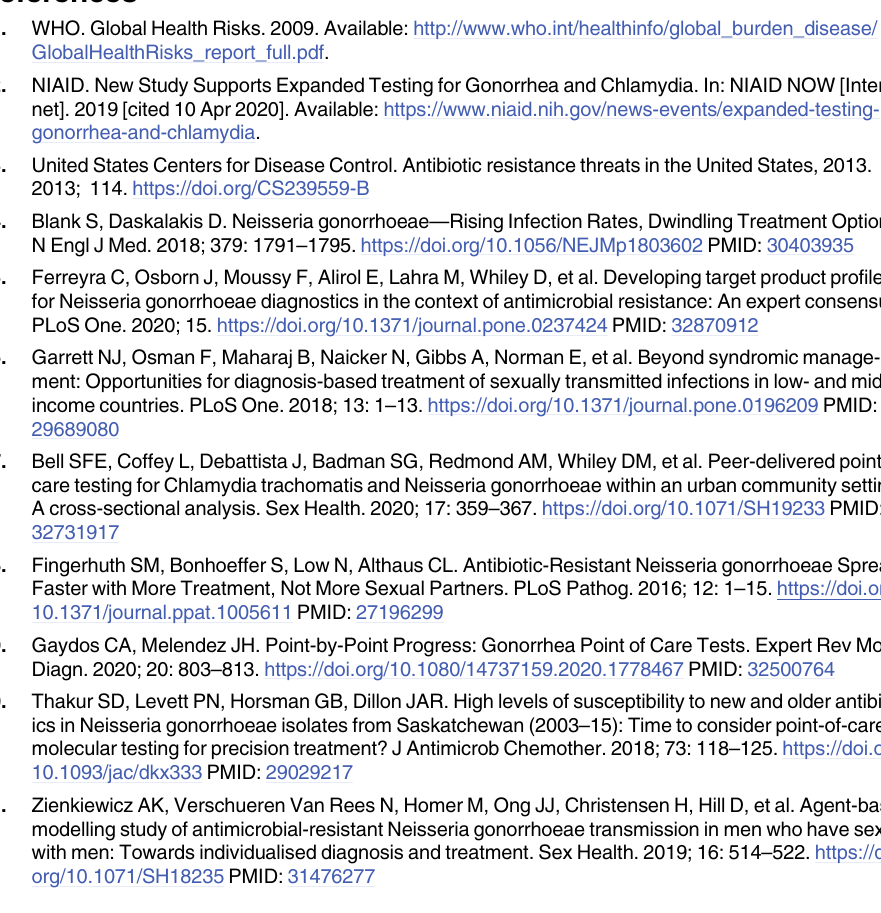
S3 Fig. NBT strain variation. Top: N . gonorrhoeae strains incubated for 24 hours with 0.1mg/mL NBT added at 23 hours. Bottom: N . gonorrhoeae strains incubated for 24 hours with 0.1mg/mL NBT added at 0 hours. (TIF) S4 Fig. XTT strain variation. Top: N . gonorrhoeae strains incubated for 24 hours with 0.1mg/mL XTT added at 23 hours. Bottom: N . gonorrhoeae strains incubated for 24 hours with 0.1mg/mL XTT added at 0 hours.